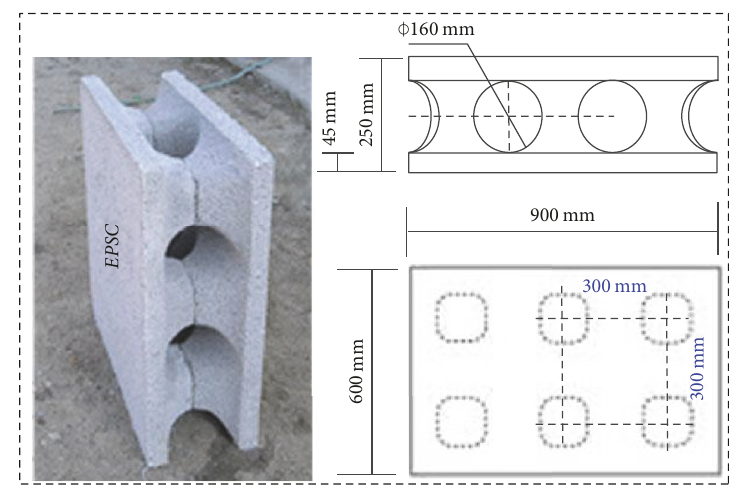
Figure 4: Specification and dimension of